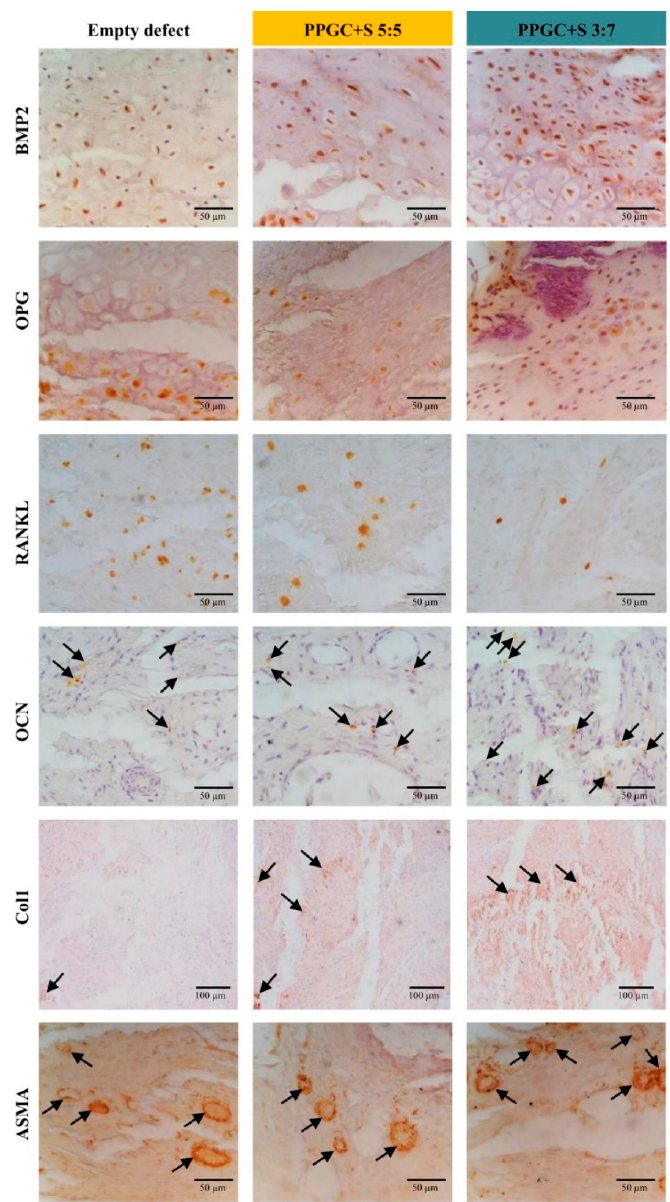
Figure 9. Immunohistochemistry on undecalcified Technovit sections showing expression of potential biomarkers involved in bone formation and resorption. Expression of bone morphogenetic protein-2 (BMP2), osteoprotegerin (OPG); receptor activator of nuclear factor kappa-B ligand (RANKL), collagen type I, and alpha-smooth muscle actin (ASMA) are shown in the ROI for the empty defect as well as PPGC + S 5:5 and PPGC + S 3:7. Additionally, OPG expression is shown in an overview. Only dark brown stains for osteocalcin (OCN) and type I collagen (Col1) marked with black arrows were used for analysis (to avoid the analysis of non-specific staining). For ASMA, blood vessels larger than the size of a cursor head were taken into count to avoid bias (indicated by arrows). A histomorphometrical analysis of the biomarker expression is provided in Figure